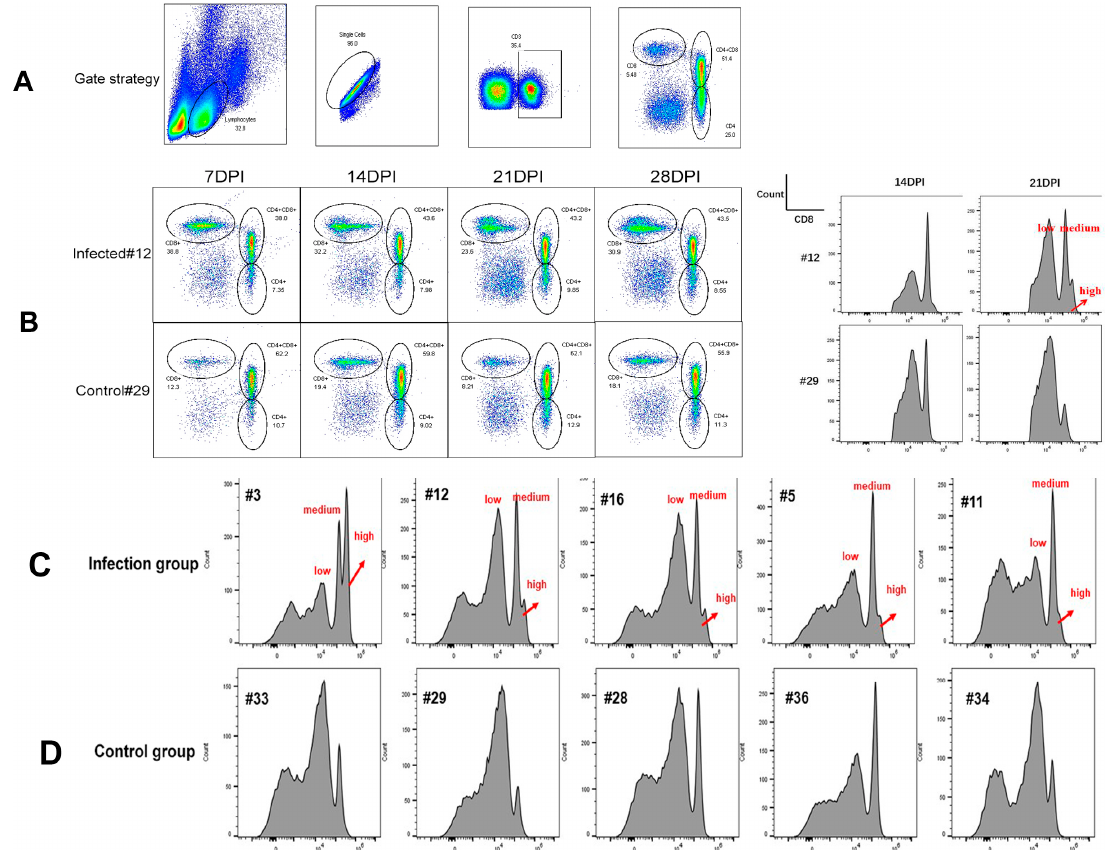
Figure 6. T cell phenotype analysis. ( A ) Gating of CD8 α + , CD4 + , and CD4 + CD8 α + T cells with the CD3 + (APC), CD4 + (FITC), and CD8 α + (PE) antibodies. ( B ) Analysis of the percentage and phenotype of T cells in PBL of ALV-J infected chicken number 12 and control chicken number 29 at various time points. Histogram of the CD3 + CD8 α + T cells in PBL of ( C ) ALV-J infected group and ( D ) control group at 21 DPI. Each sample collected 1 × 10 5 cells for flow cytometric